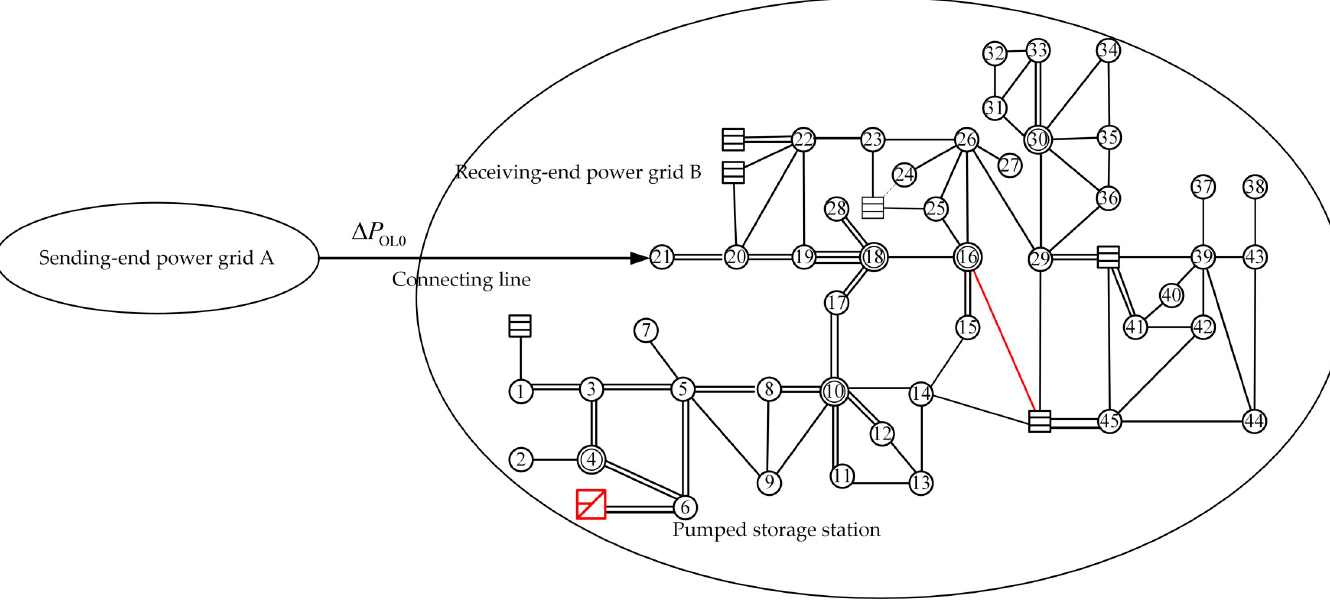
Fig 11. Simulated test power